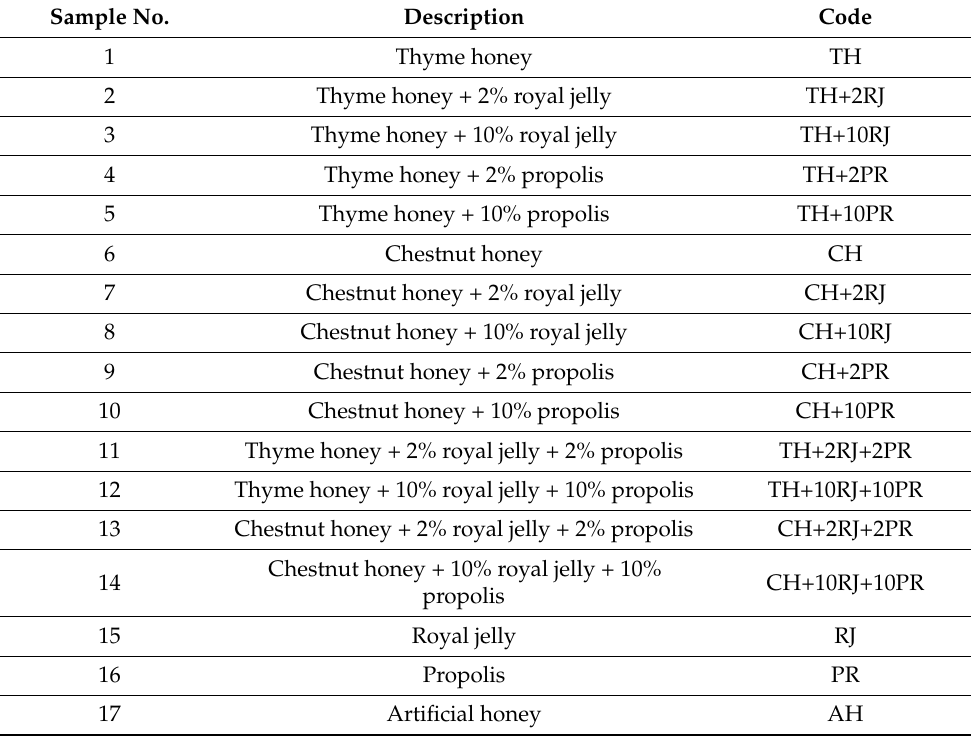
Table 2. Honey and bee products samples and